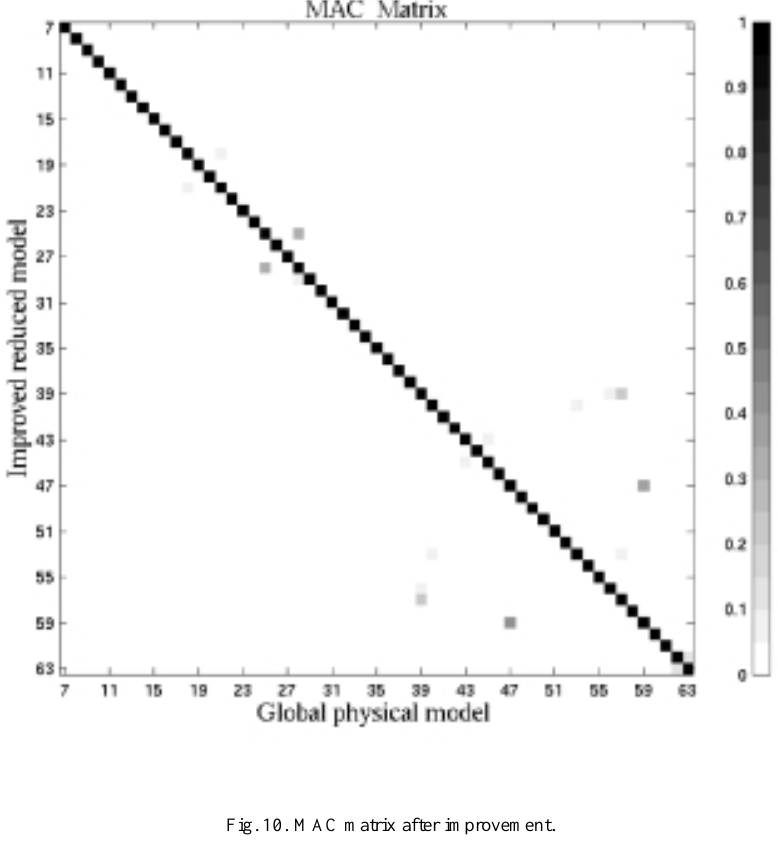
Fig. 10. MAC matrix after